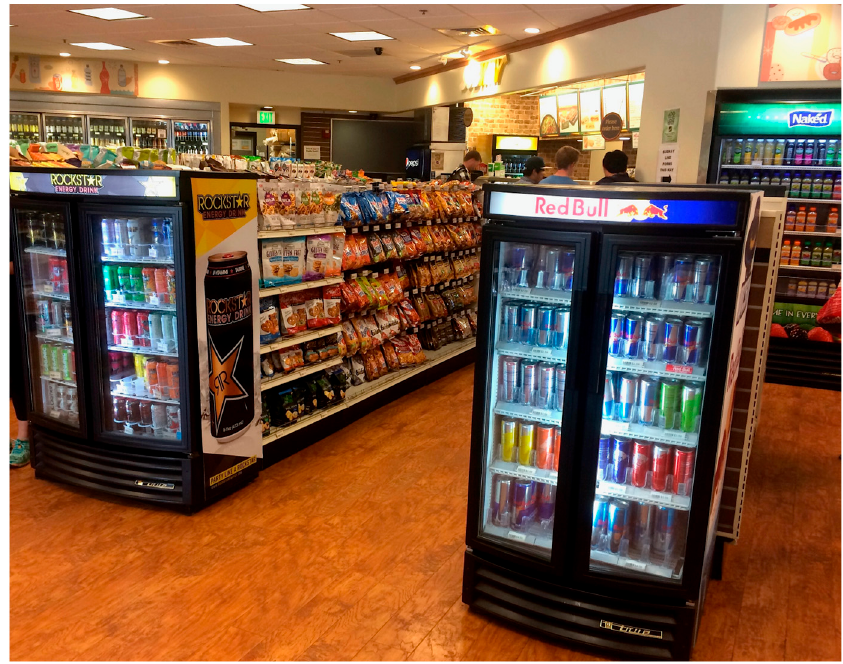
Figure 1. Convenience store on a PHEI campus. Credit: © D.A. Cleveland, used with permission.